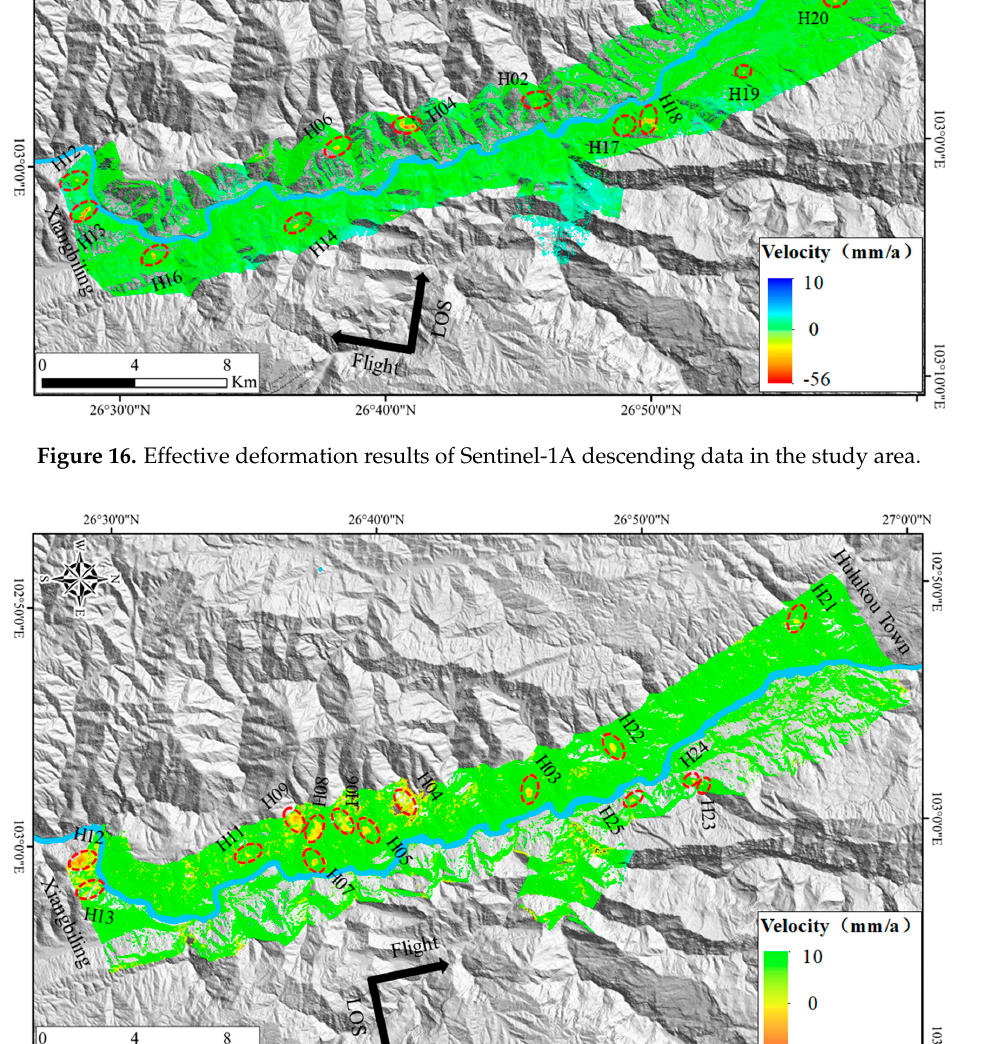
Figure 17. Effective deformation results of ALOS PALSAR ascending data in the study area.